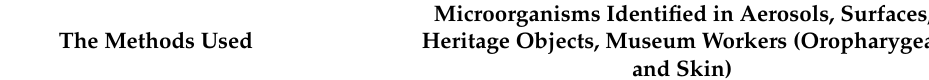
Table 1. Summary of important research in the specialized literature aimed at determining microbiological contamination in